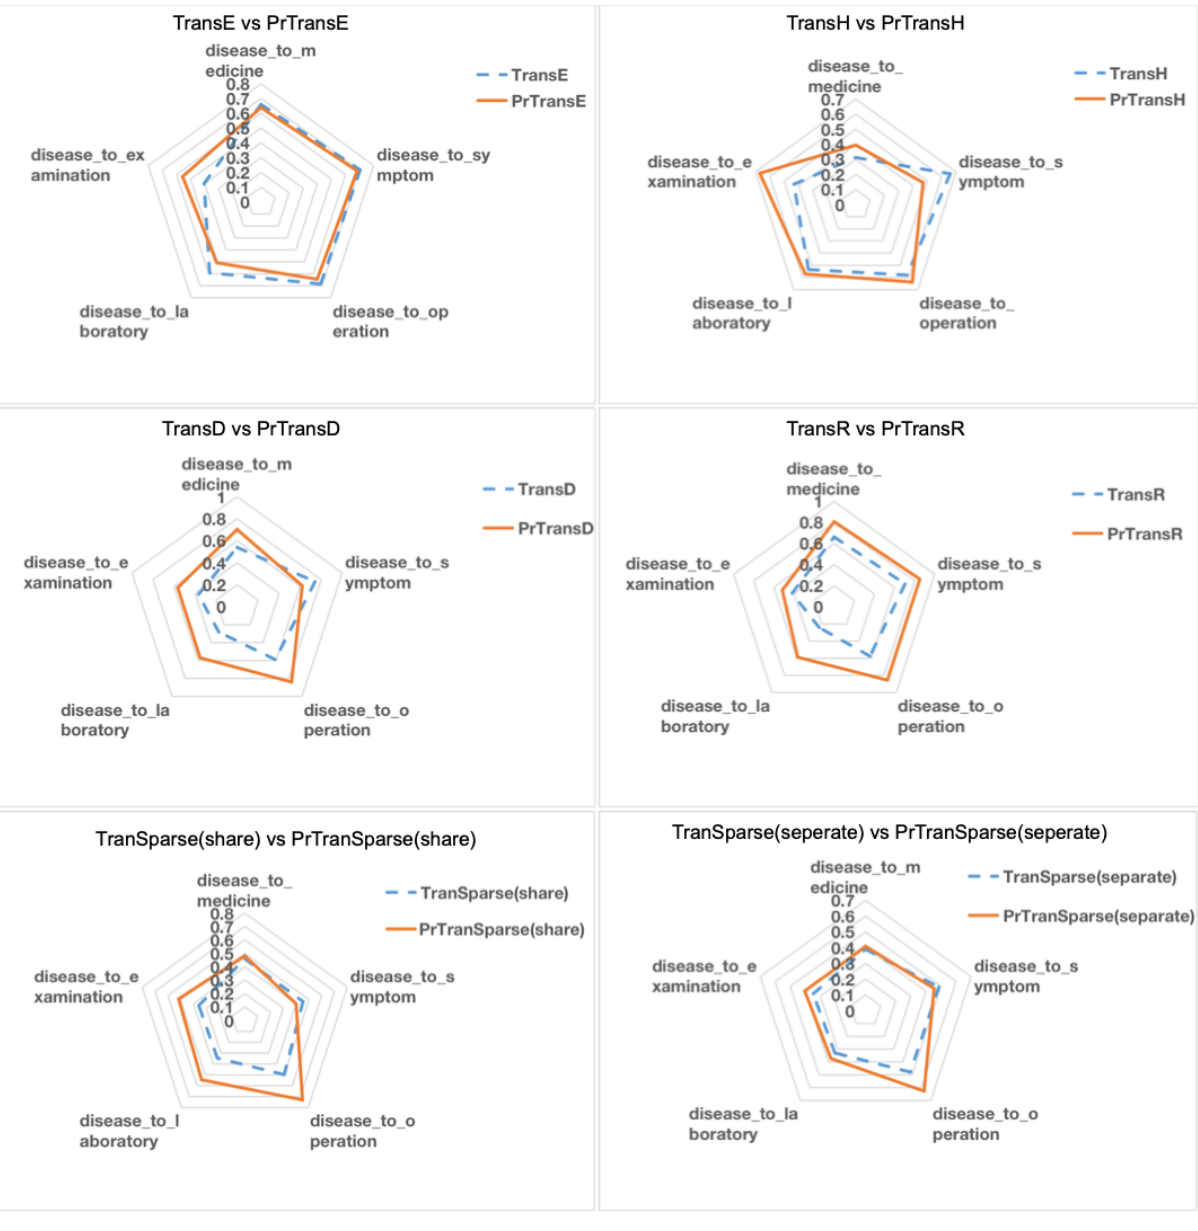
Figure 7. Comparison of normalized discounted cumulative gain of the top 10 predicted tail entities of TransX and PrTransX by different